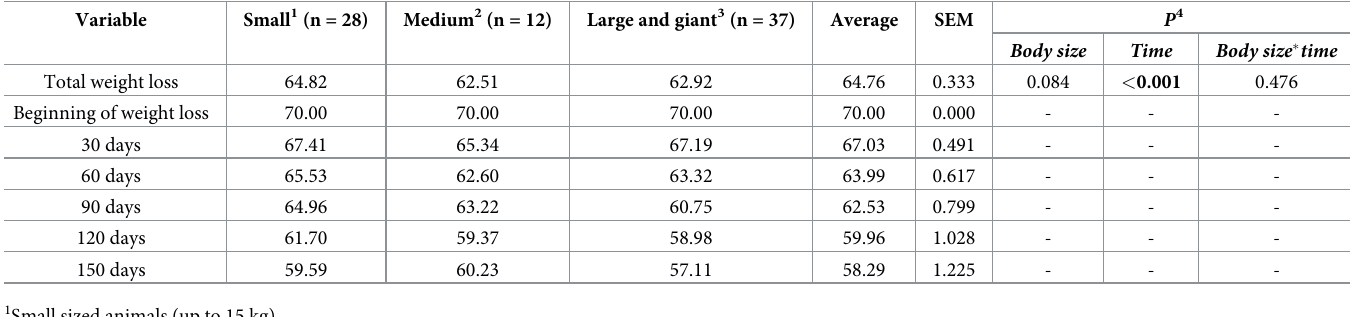
Table 3. Calorie intake per target weight 0.75 according with body size.